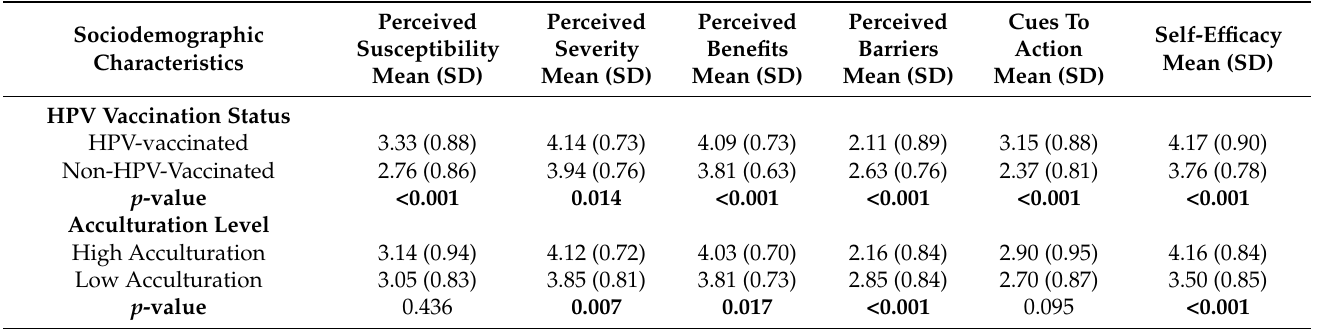
Table 6. Mean HBM constructs score across different HPV vaccination statuses and acculturation levels of foreign-born college students, mean